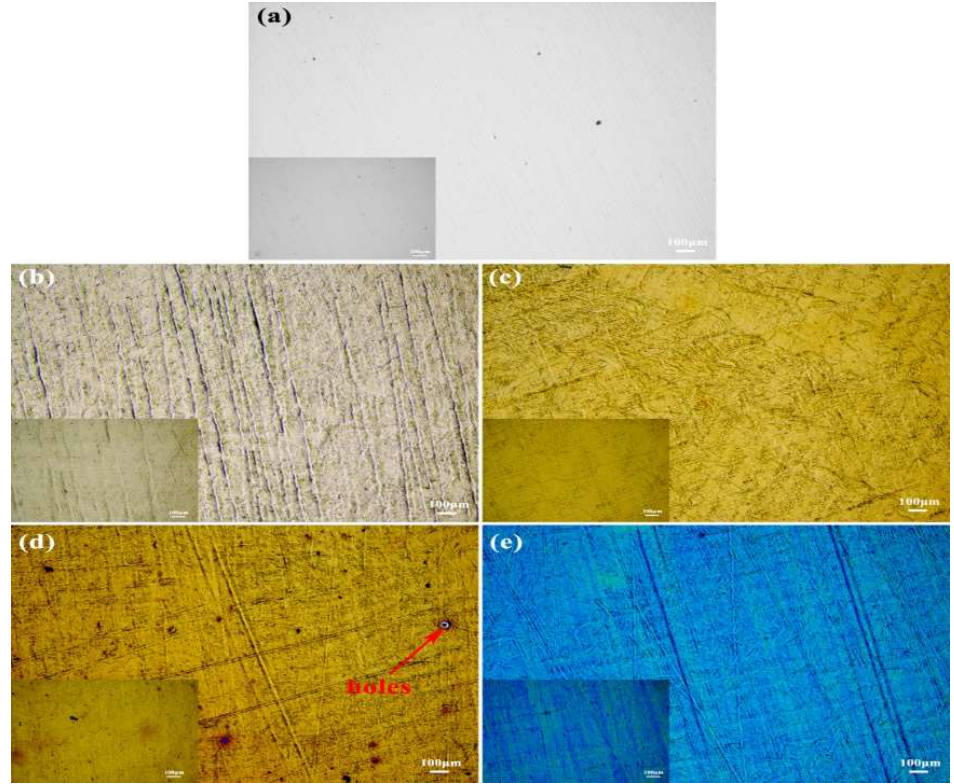
Figure 4. Surface morphologies of samples before and after femtosecond laser ( a ) As-fabricated ( b ) 10 µ m ( c ) 5 µ m ( d ) 3 µ m ( e ) 1 µ